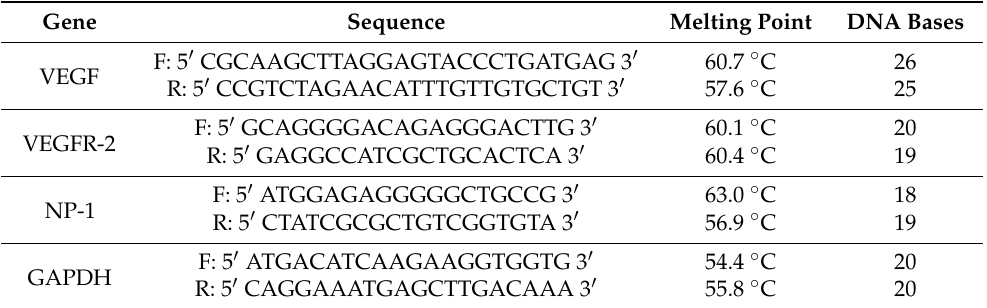
Table 1. qPCR primers used for expression